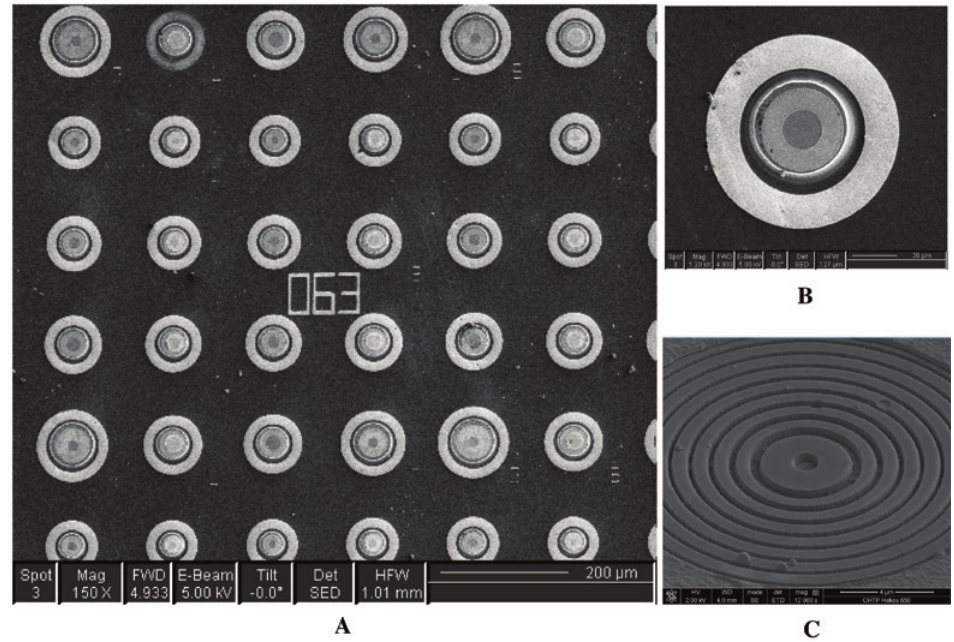
Figure 6: FIB Fabrication results of (A) SEM micrograph of the VCSEL array on wafer before integration, (B) zoom-in picture of a single VCSEL before integration, (C) after integration of the metalens through FIB milling.